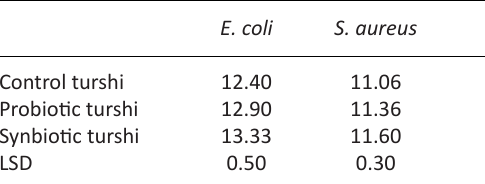
Table 4. Antagonistic activity (mm) of Control turshi, Probiotic turshi and Synbiotic turshi samples against E. coli and S.